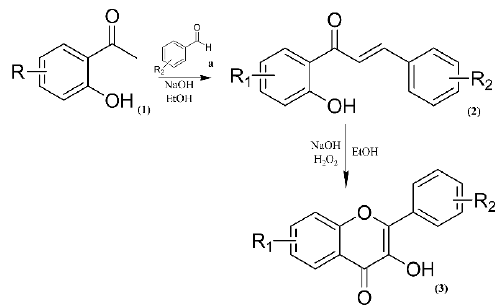
Figure 2. Synthetic route to obtain flavonol-like compounds.